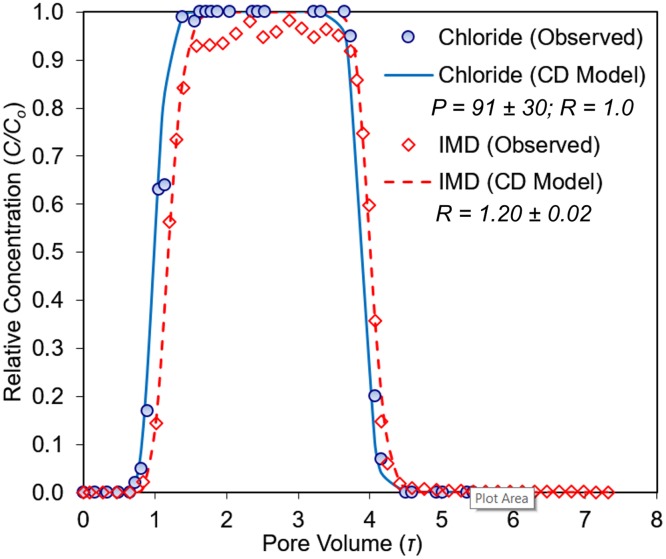
Imidacloprid (IMD) and tracer (Cl-) BTC from the E-horizon column and corresponding transport parameters.Solid lines indicate the optimized transport models (CD).